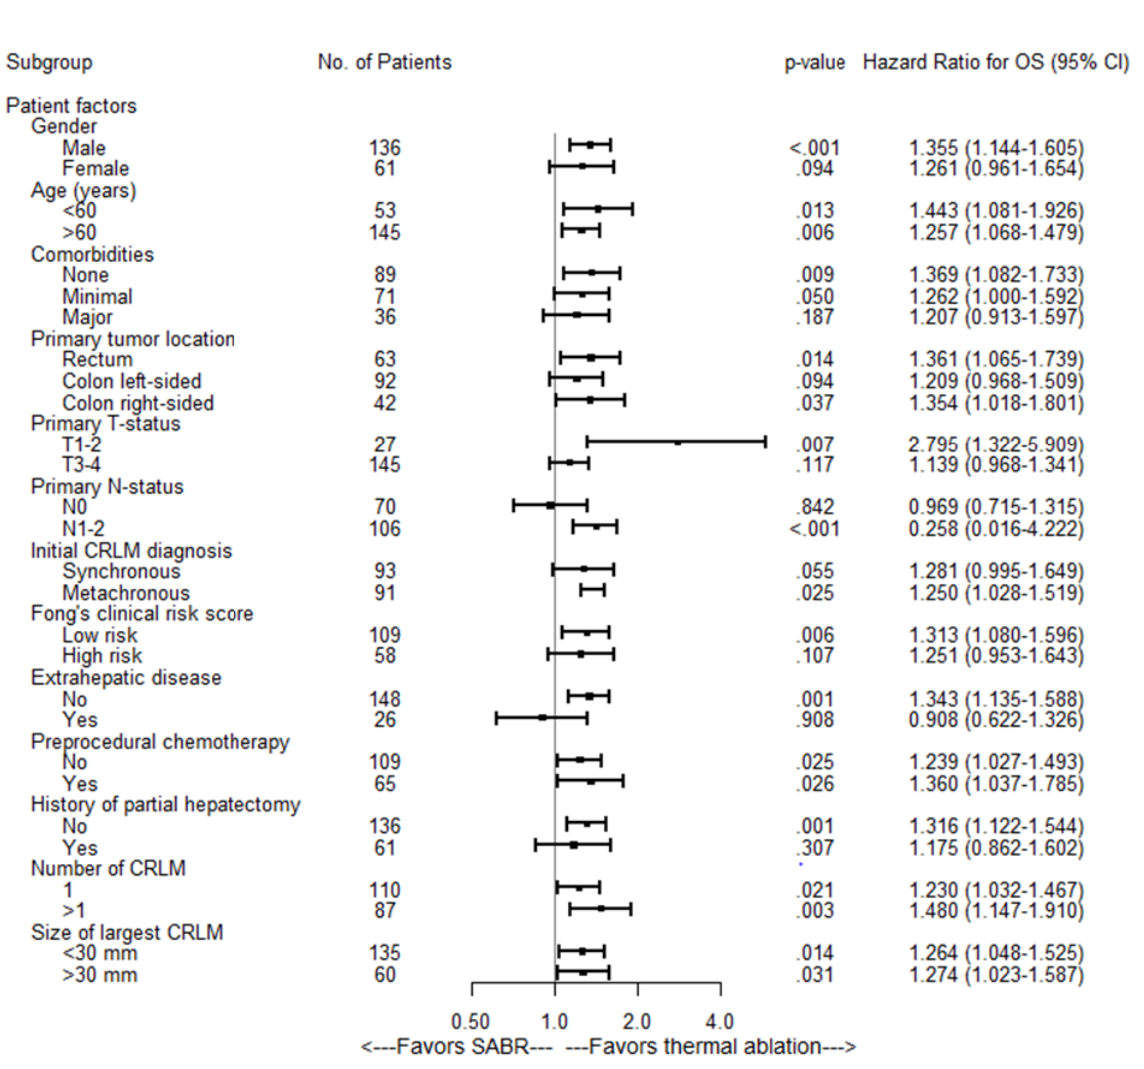
Figure 4. Univariate Subgroup Cox Regression Analyses of SABR versus thermal ablation associated with OS.